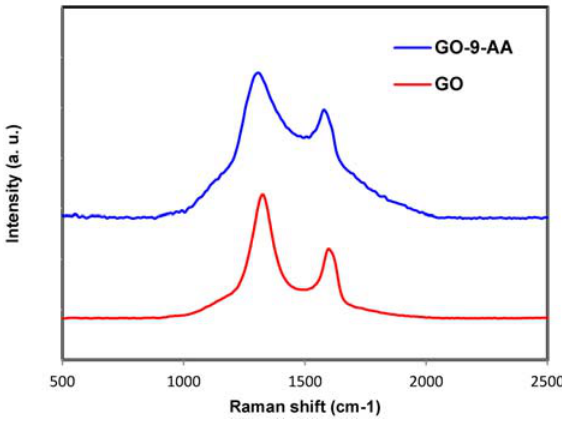
Fig. 2. Raman spectra of GO and